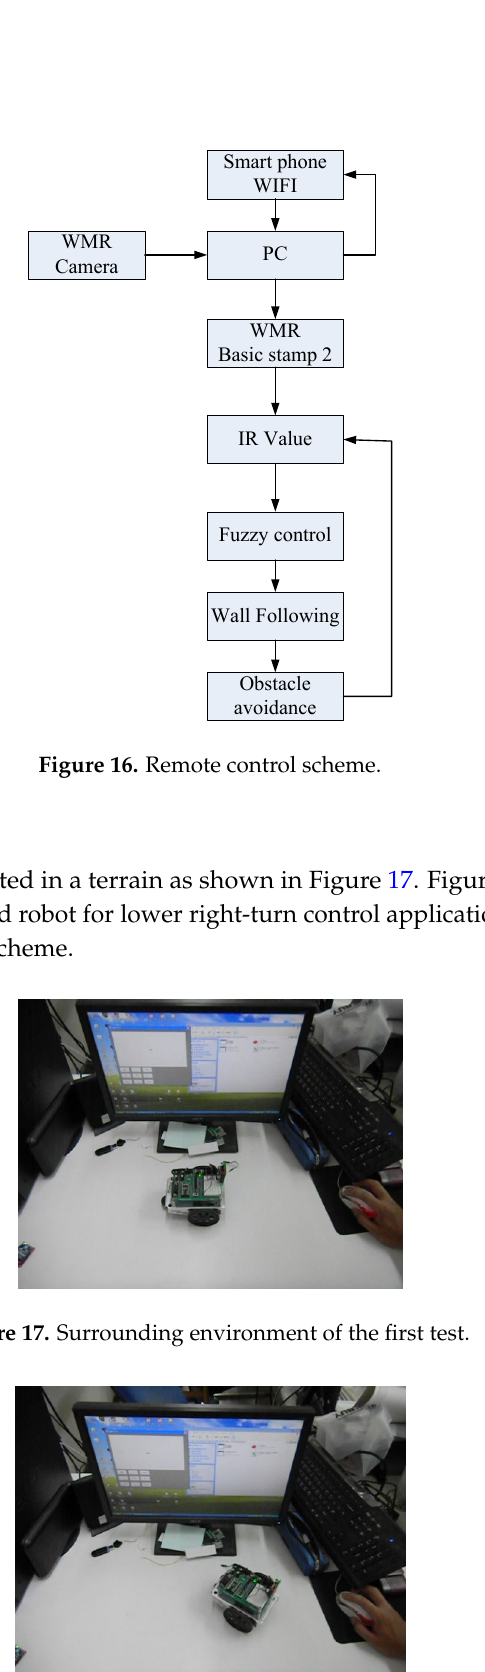
Figure 18. PC ‐ based control operation example: lower right movement.